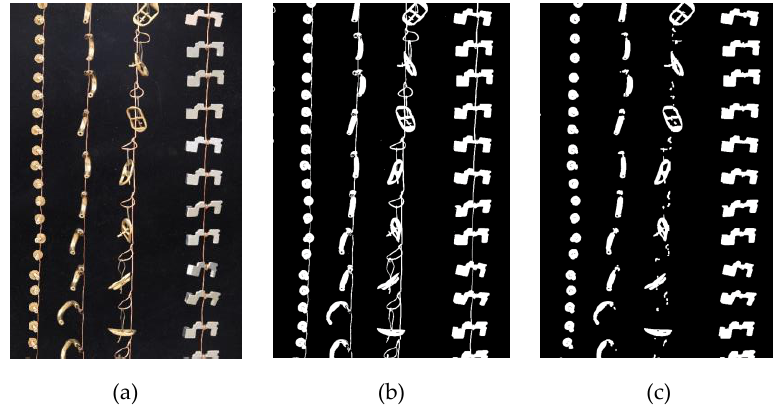
Figure 5. ( a ) Acquired image using the first setup: ( b ) Image after thresholding and ( c ) image after morphological opening.